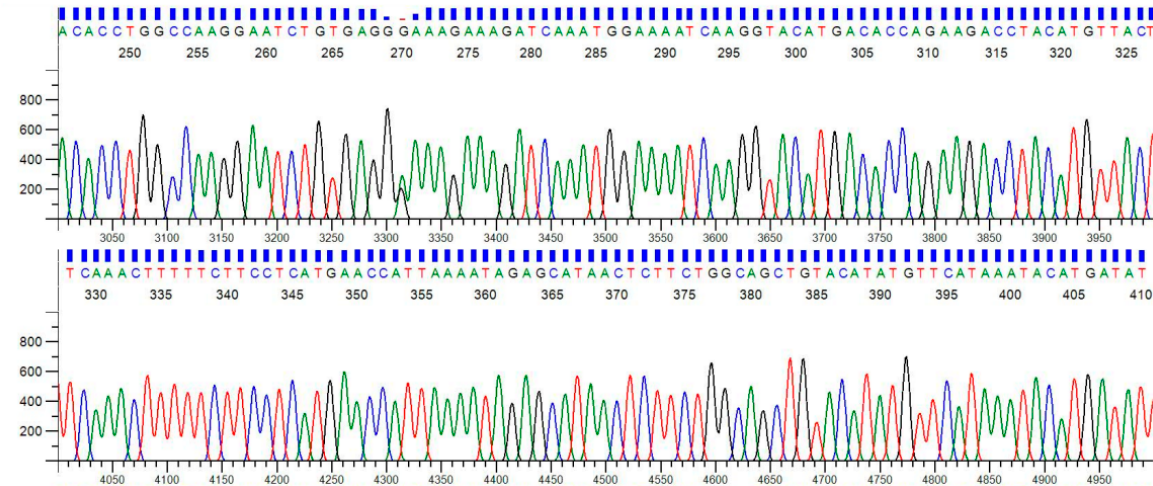
Figure 9. Forward pattern of a representative partial chromatogram of IL17A where each nitrogenous base is represented by a specific colour: adenine (green), guanine (black), thymine (red), and cytosine (blue).